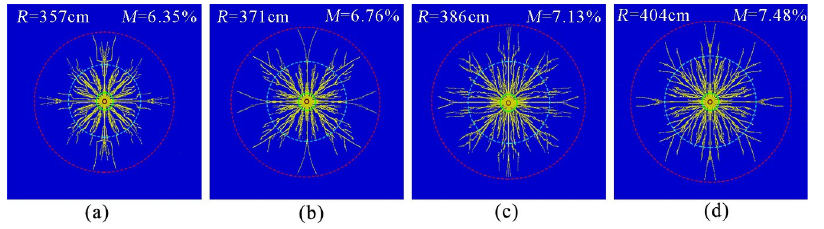
Fig 11. Crack distribution at different peak relief pressure. (a)Pressure peak 180 MPa.(b)Pressure peak 210 MPa.(c) Pressure peak 240 MPa (d)Pressure peak 270